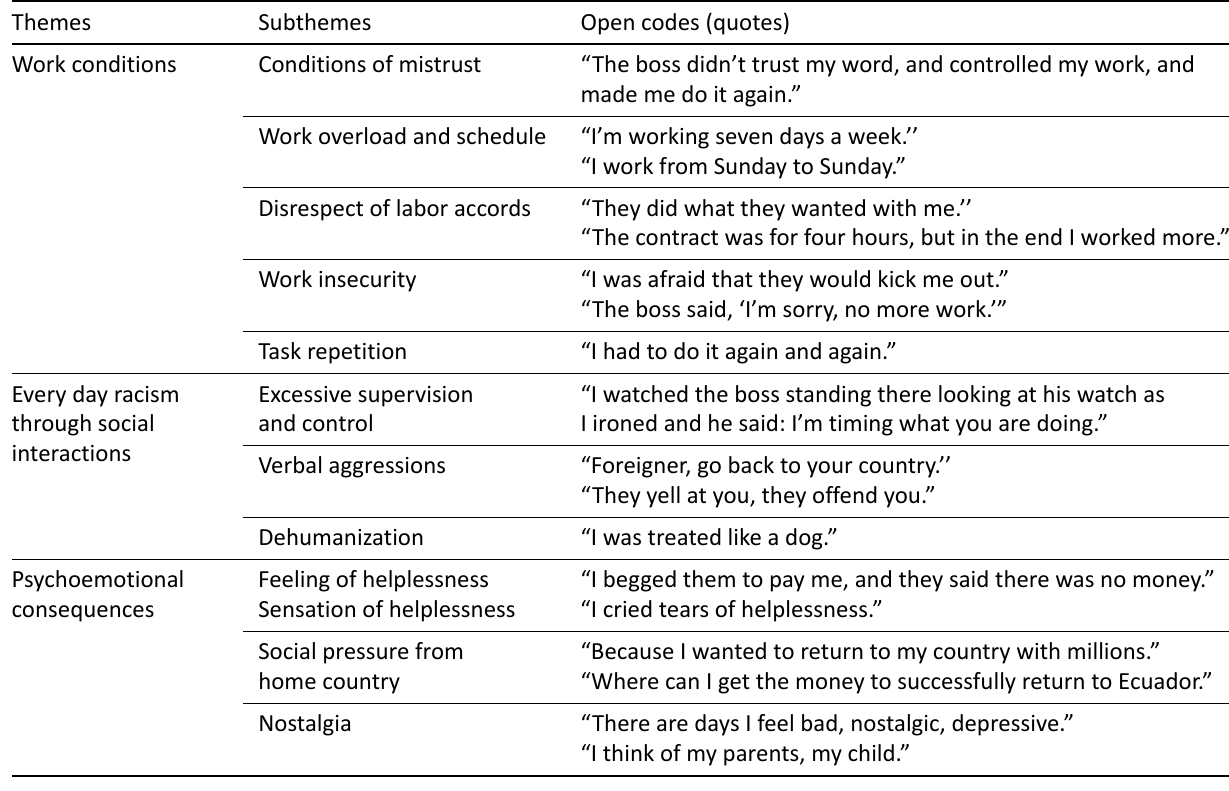
Table 1. Themes, subthemes, and open codes of the